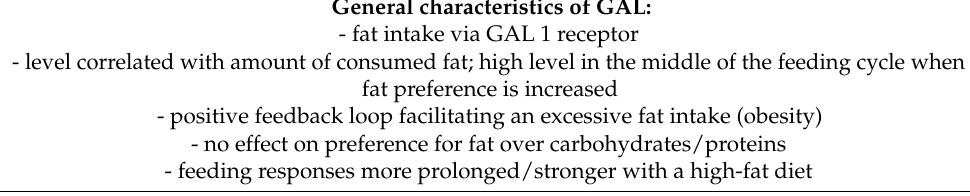
Table 1. GAL family of peptides and food intake: general findings [2,38]. General characteristics of